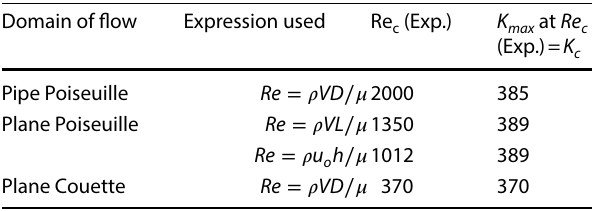
and K (Adapted from Dou [4] and c max